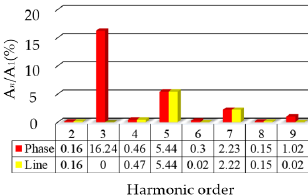
Figure 10. The percentage of each harmonic components of back-EMF relative to the fundamental wave.